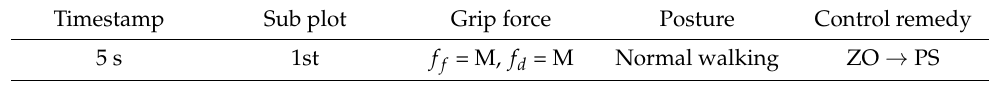
Table 11. Summary of experimental results (Flat surface: v = ZO, S g = ZO). Timestamp Sub plot